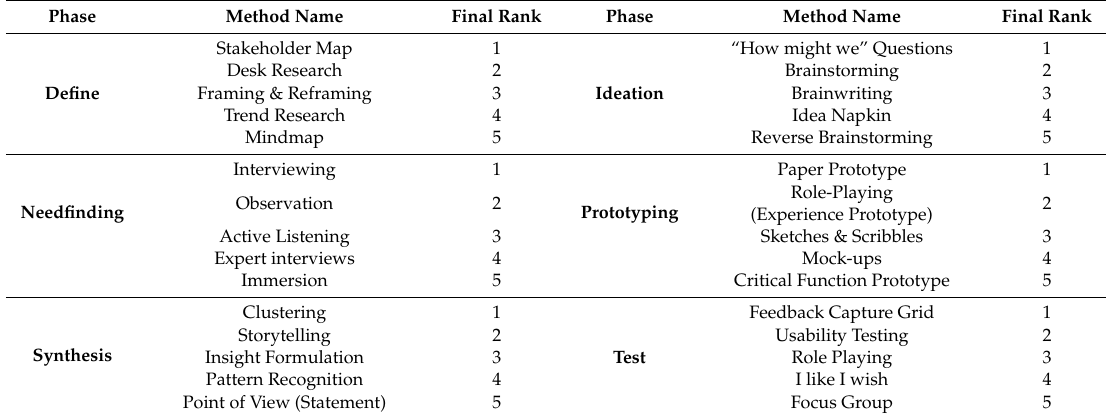
Table 1. Use Ranking Design Thinking (DT) methods. Adapted from